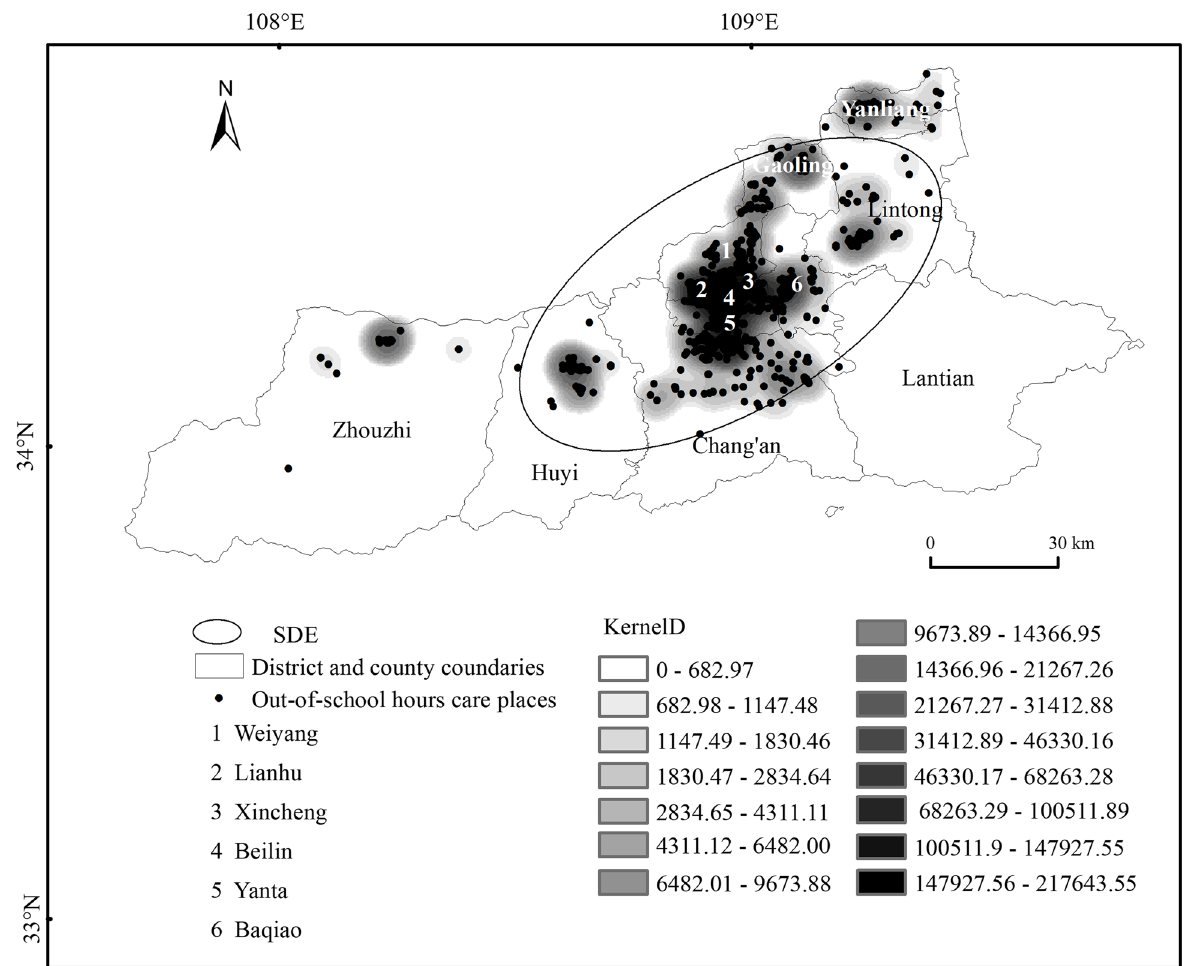
Fig. 2 Kernel density map of out-of-school hours care places in Xi’an in autumn 2021